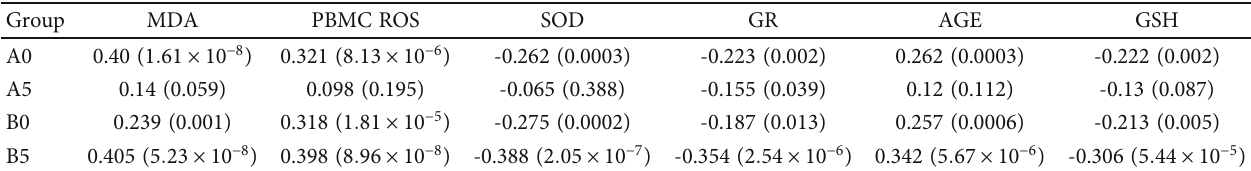
A0: baseline levels of di ff erent parameters of Group A; A5: levels of di ff erent parameters of Group A after 5 years; B0: baseline levels of di ff erent parameters of Group B; B5: levels of di ff erent parameters of Group B after 5 years; PBMC ROS: peripheral blood mononuclear cell reactive oxygen species; MDA: malondialdehyde; SOD: superoxide dismutase; GR: glutathione reductase; GSH: reduced glutathione; AGE: advanced glycation end products; VEGF: vascular endothelial growth factor. Two sets of paired observations were compared by paired t -test; p value < 0.05 was considered statistically signi fi cant. Table 3: Correlation of VEGF with di ff erent biochemical parameters (represented with correlation coe ffi cient “ r ” with “ p value ” ) at baseline and after 5 years of two study groups.